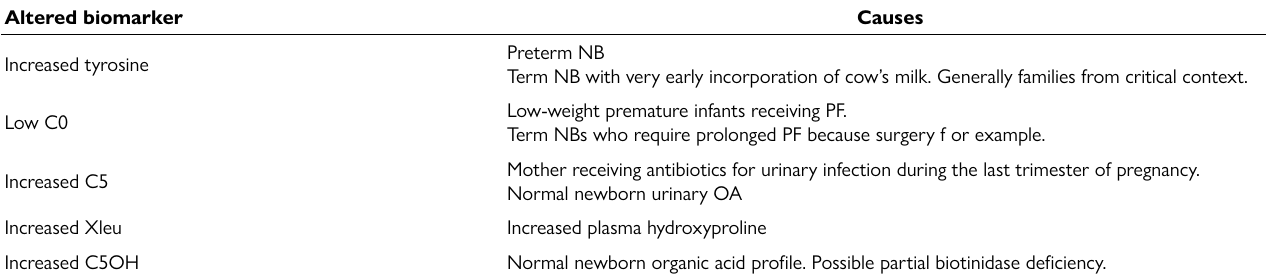
C0: free carnitine. C3: propionylcarnitine. C5: isovalerylcarnitine/2-methyl butirylcarnitine. Xleu: leucine/isoleucine/hydroxyproline. C5OH: hydroxyisovalerlcarnitine. PF: parenteral feeding. OA: organic acids. NB: